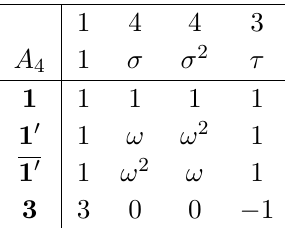
Table 2. Character table of A 4 , the alternating group of order 4 . Conjugacy classes are labelled by a representative element with the numbers of elements in each class atop. ω is a cube root of